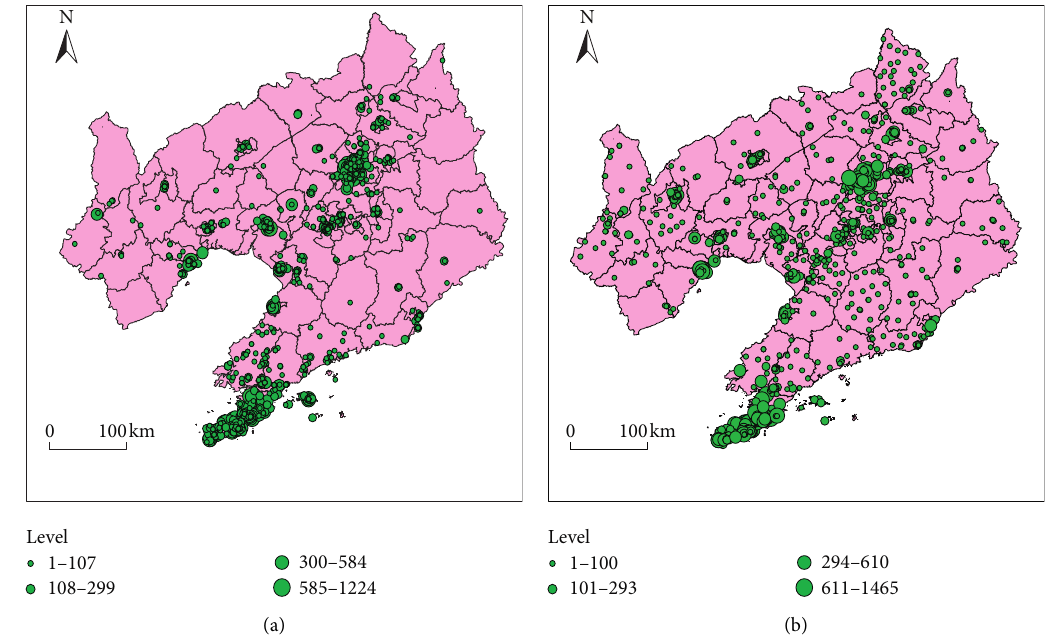
Figure 3: Spatial variation of the scale of primary schools in Liaoning Province (a) in 2008 and (b) 2017.